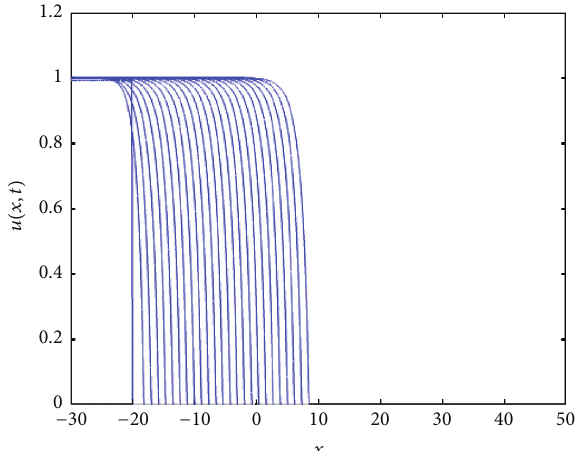
Figure 9: Evolution of a compact support function as initial condi- tion under the reaction-diffusion convection process described by (14). The numerics show that as the time grows, the approximative solution tends to the sharp traveling wave solution. Profiles are plotted at equal time intervals 𝑡 = 1, 2, 3, .. . with 𝑔(𝑢) = 𝑢(1 − 𝑢) and 𝐷(𝑢) = 𝑢(1.0 + 𝛽𝑢) for 𝛽 = 1 and ℎ 󸀠 (𝑢) = 𝑘𝑢 , with 𝑘 = 1 .